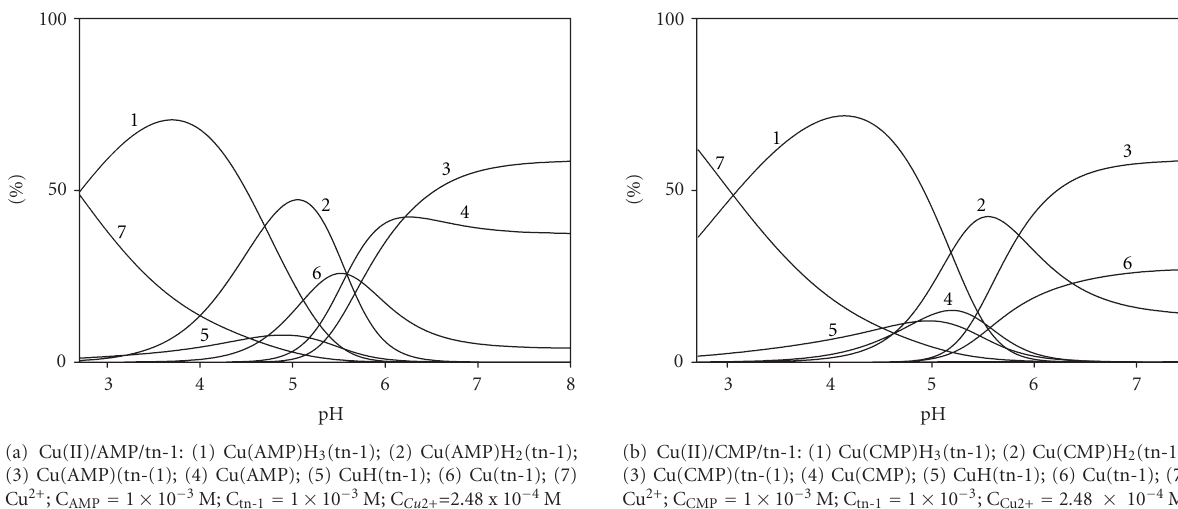
Figure 5: Distribution diagrams for the Cu(II)/AMP/tn-1 and Cu(II)/CMP/tn-1 systems; percentage of the species refers to total metal.